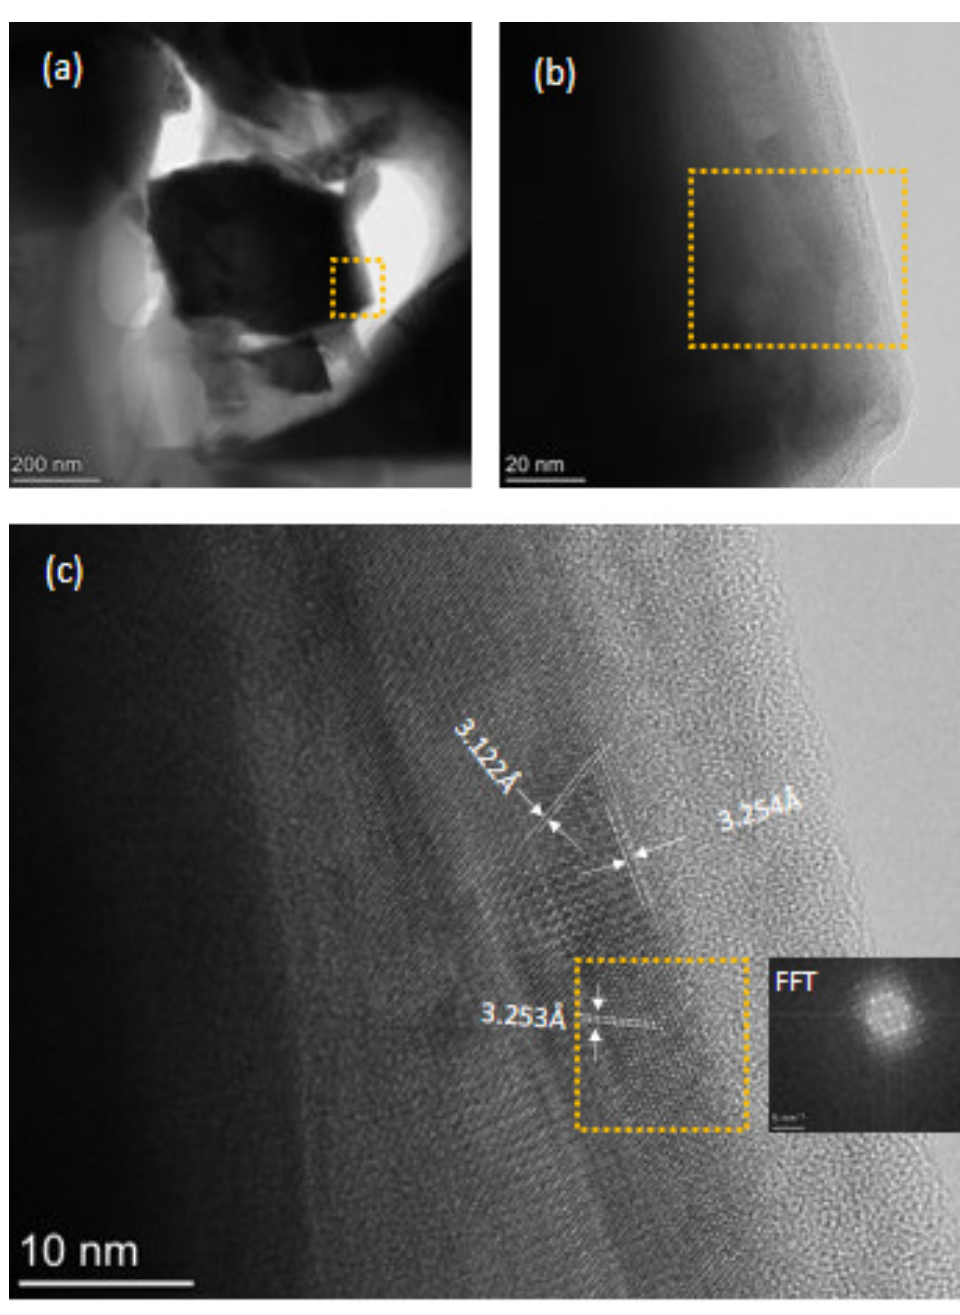
Figure 17. TEM image from STEM (Scanning TEM)-EDS region 0940 at low magnification ( a , b ) (scales = 200 nm and 20 nm, respectively) and high magnification ( c ) (scale = 10 nm). HRTEM image and the lattice interlayer space of the area blocked in STEM/EDS Region 0940.